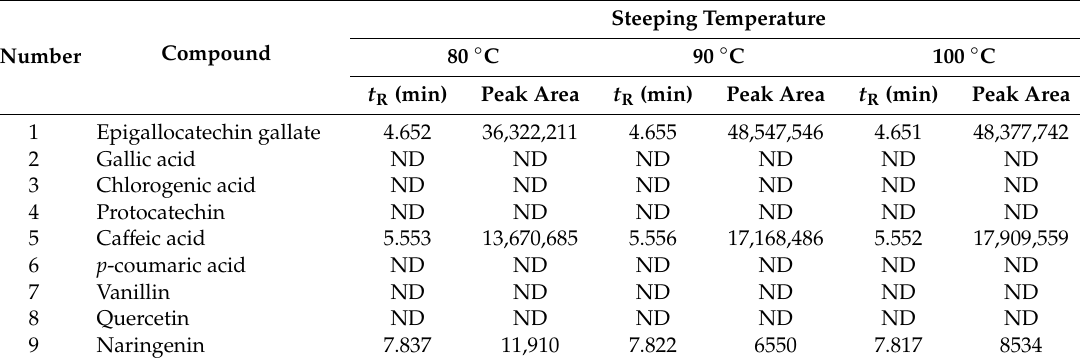
Table 6. Phenolic composition of infusions obtained from commercial green tea from leaves of Camellia sinensis prepared at di ff erent steeping temperatures (80, 90, and 100 ◦ C) identified by high-performance liquid chromatography